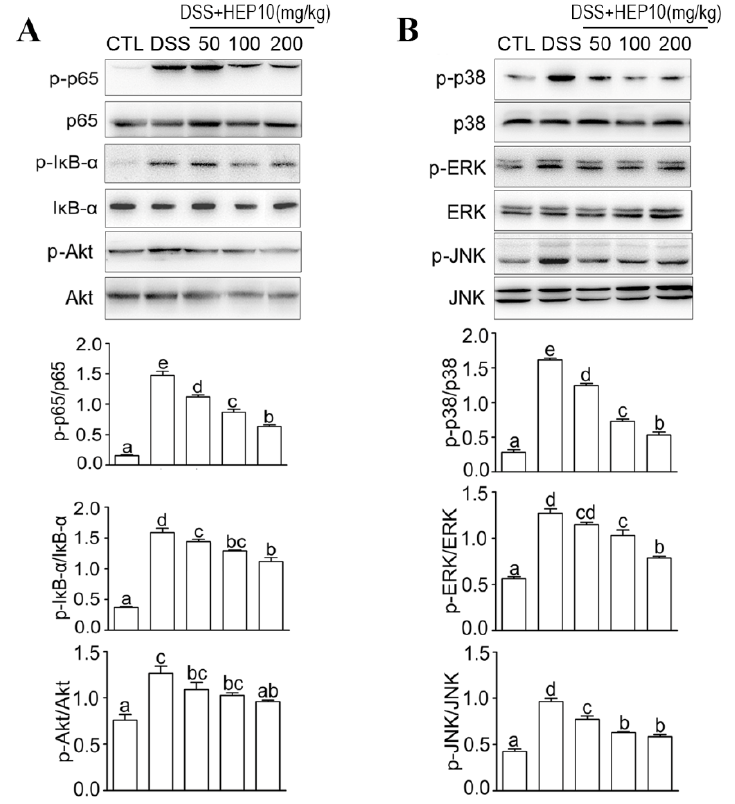
Figure 7. HEP10 inhibited NF- κ B, Akt, and MAPK signaling in colon tissues of mice with DSS- induced colitis. Protein expression levels of phosphorylated p65, I κ B, and Akt determined by Western blotting ( A ), P38, ERK, and JNK ( B ). The membranes were re-probed with antibodies against total p65, I κ B, Akt, P38, ERK, and JNK for normalization. The data is presented as means ± SD ( n = 5). Different alphabetic letters refer to significant differences ( p < 0.05, two sided).